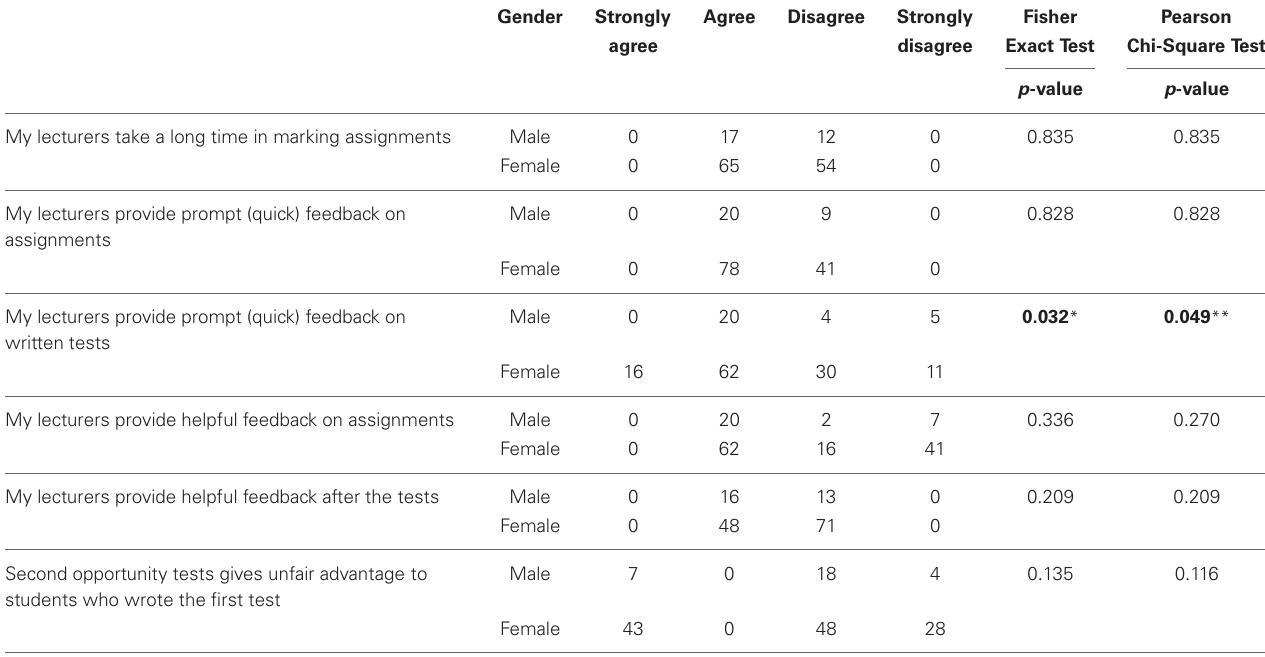
Table 4 | Continuous assessment